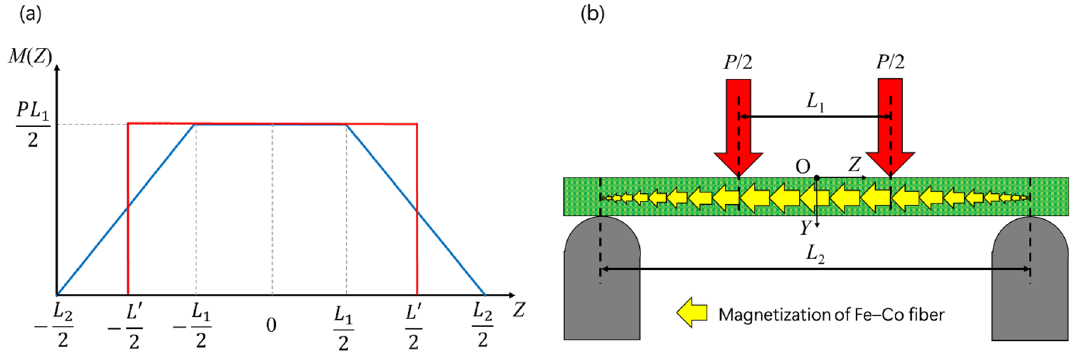
Figure 4. ( a ) Bending moment diagram of four-point bending test, and ( b ) Schematic view of four-point bending test and Fe–Co fiber